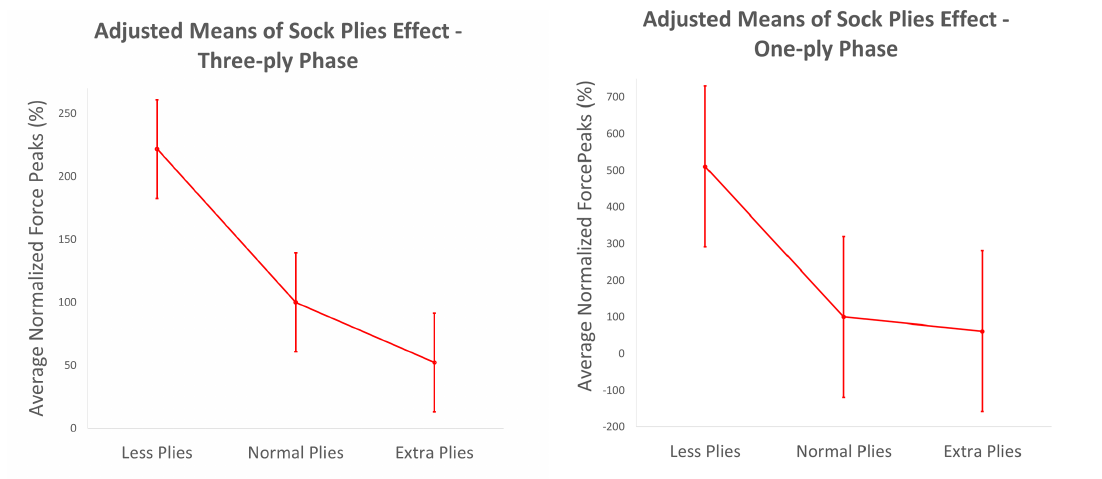
Figure 4. Results in terms of adjusted means and standard errors. Adjusted normalized means of peaks of force in the distal location across participants in the two phases of the study.